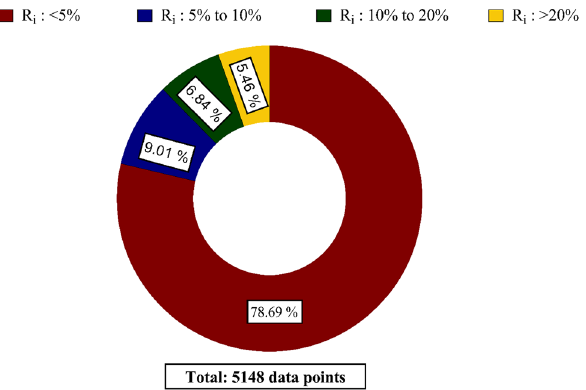
Figure 4. Distribution of relative error values for GPR model in various ranges (created by GraphPad 8.4.3.686 145